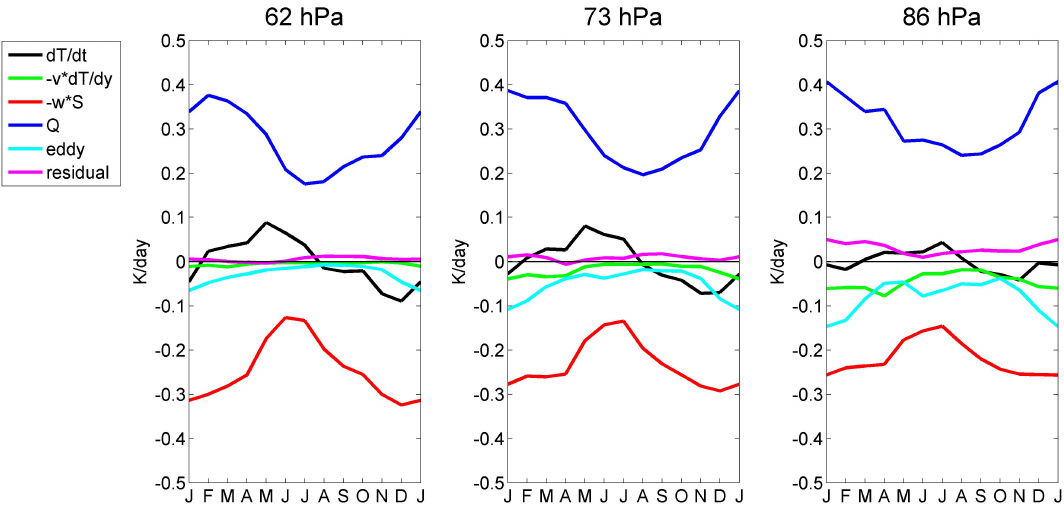
Fig. 6. Mean seasonal cycle (monthly means) of all the terms in the thermodynamic balance (Eq. 1) in WACCM computed at three pressure levels and averaged over 18 ◦ S–18 ◦